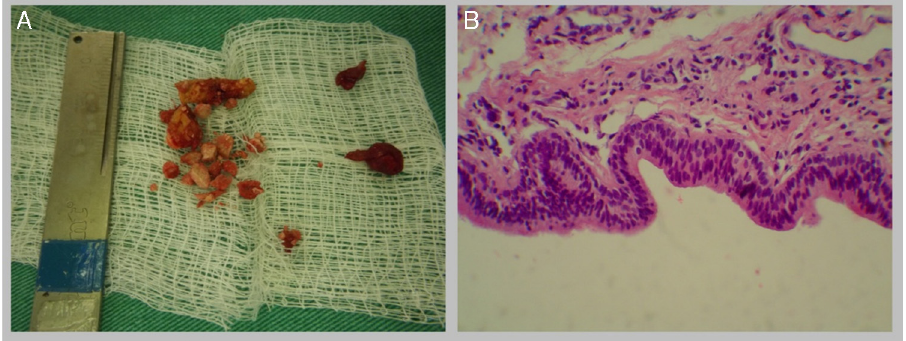
(A) The fragmented stone is seen on the left. On the right side, there is a tissue corresponding to the salivary cyst. (B) Histological section of the cyst showing oncocytic epithelium compatible with ductal epithelium (hematoxylin and eosin stain, 400 ×